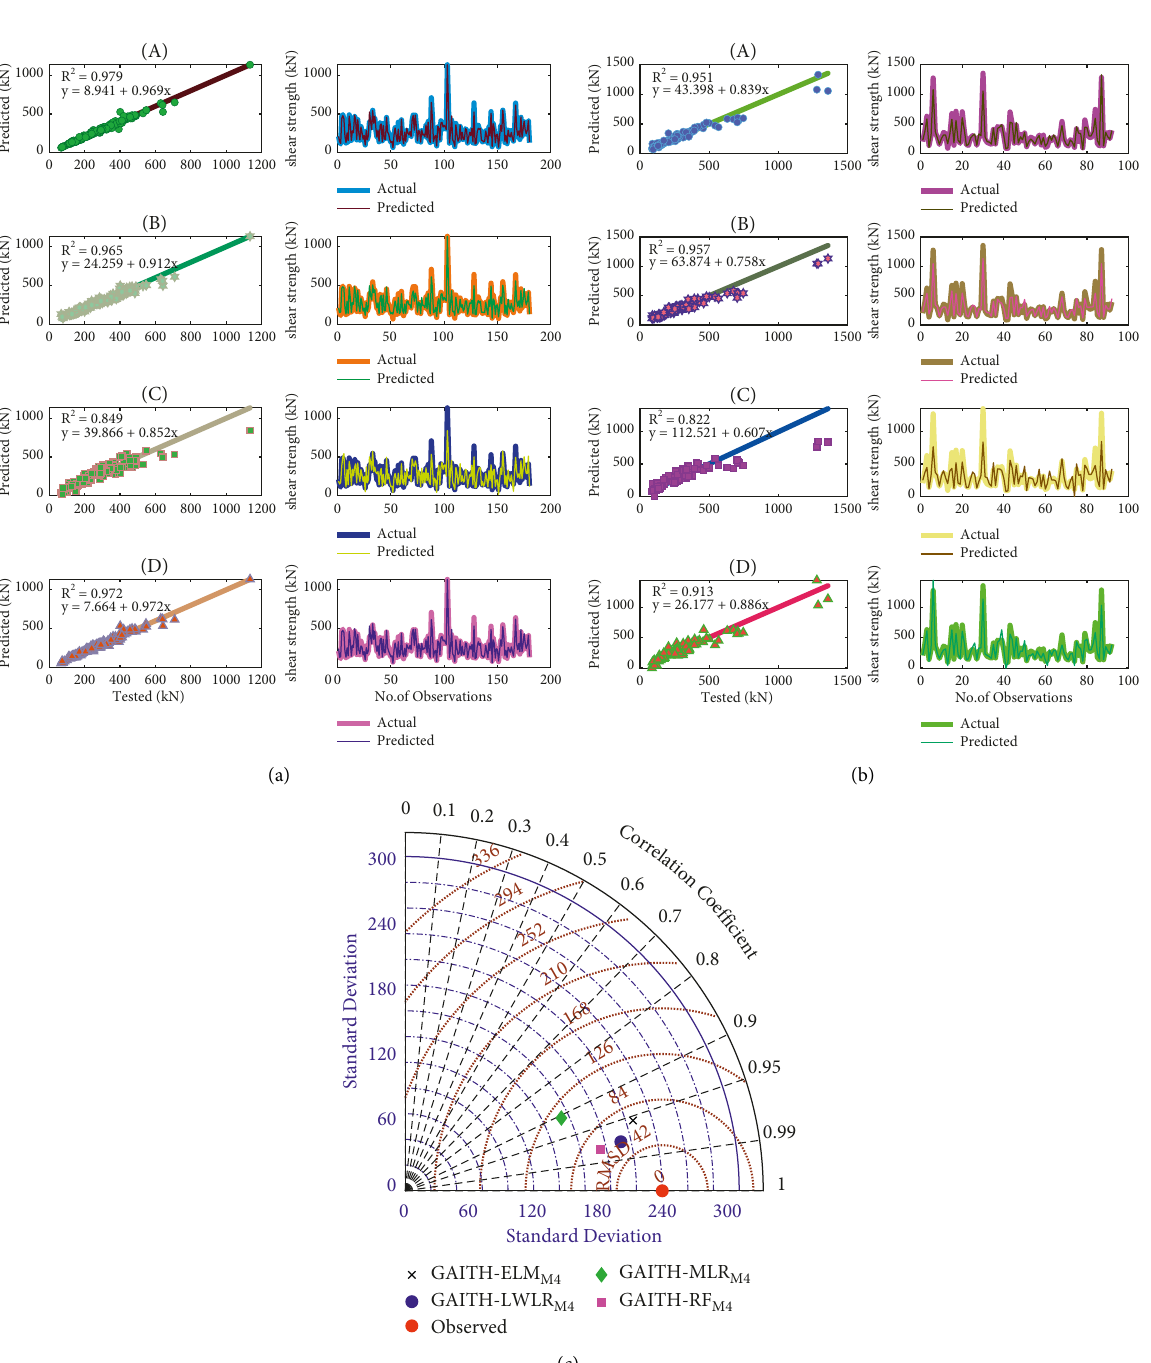
, GAITH − RF , M 4 M 4